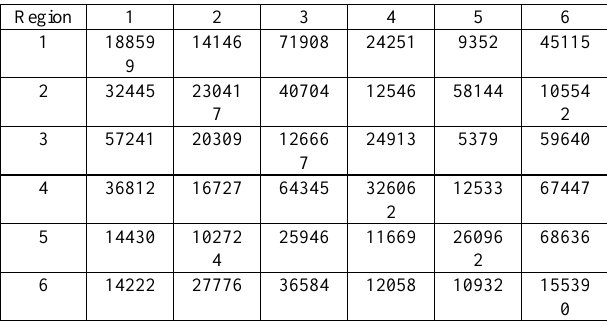
Table 1. Initialize counts of agents in scenarios Moreover, the map of case study and the schema of the application that is coded by C# language in .NET framework 4.5 using ArcObjects 10.1 is shown at figure 3.